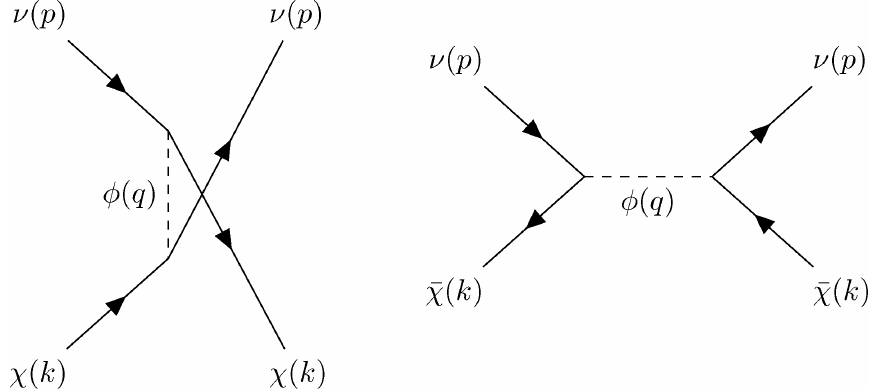
Figure 1 . Feynman diagrams for scattering of neutrinos on a background composed of fermions χ (left) and antifermions ¯ χ